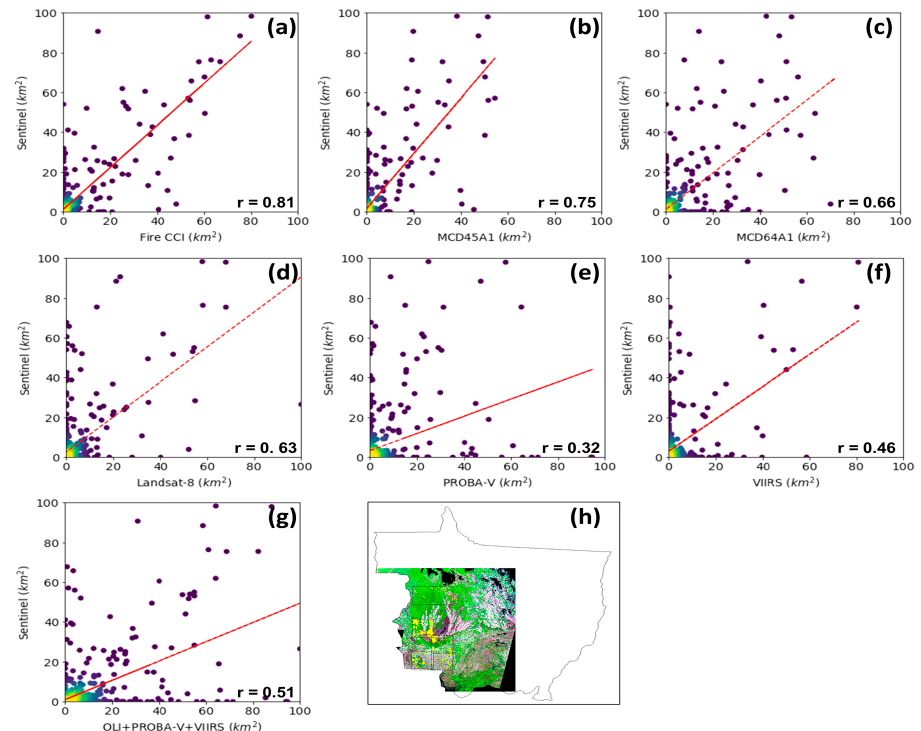
Figure 6. Assessment of burned areas mapped in S2 MSI (on y-axis) with Fire CCI ( a ), MCD45A1 ( b ), MCD64A1 ( c ), Landsat-8 OLI ( d ), PROBA-V ( e ), NPP-VIIRS ( f ), and OLI+ PROBA-V+VIIRS ( g ). Selected S2 MSI granules with burned areas in yellow ( h ). Remote Sens. 2019 , 10 , x FOR PEER REVIEW 14 of 24